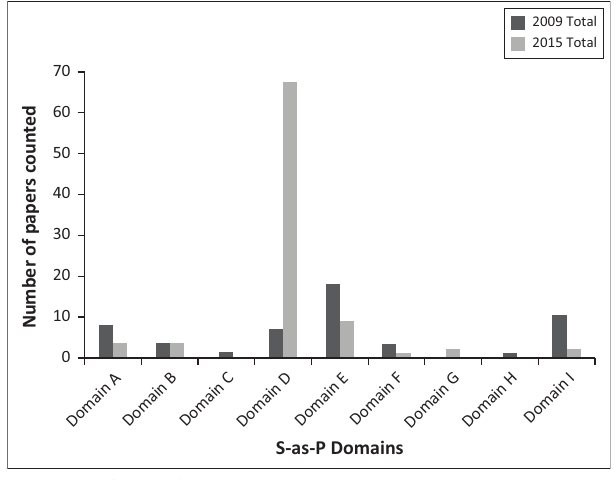
FIGURE 4: Total number of papers counted, both in 2009 and 2015, in each strategy–as–practice (S-as-P) research domain.